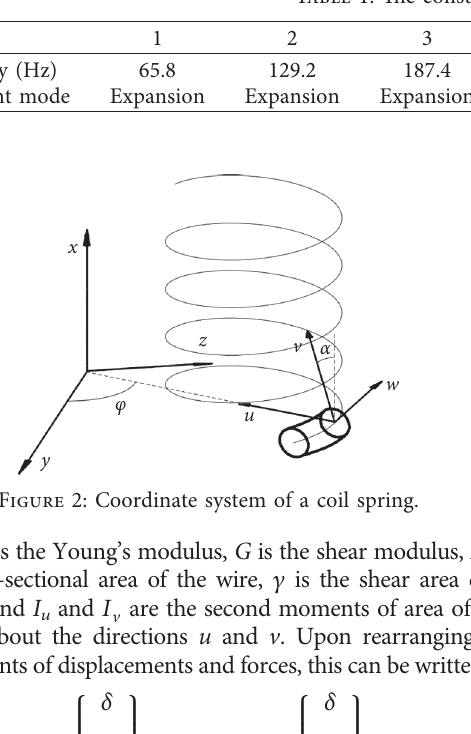
Table 1: The constrained modes of the coil spring.